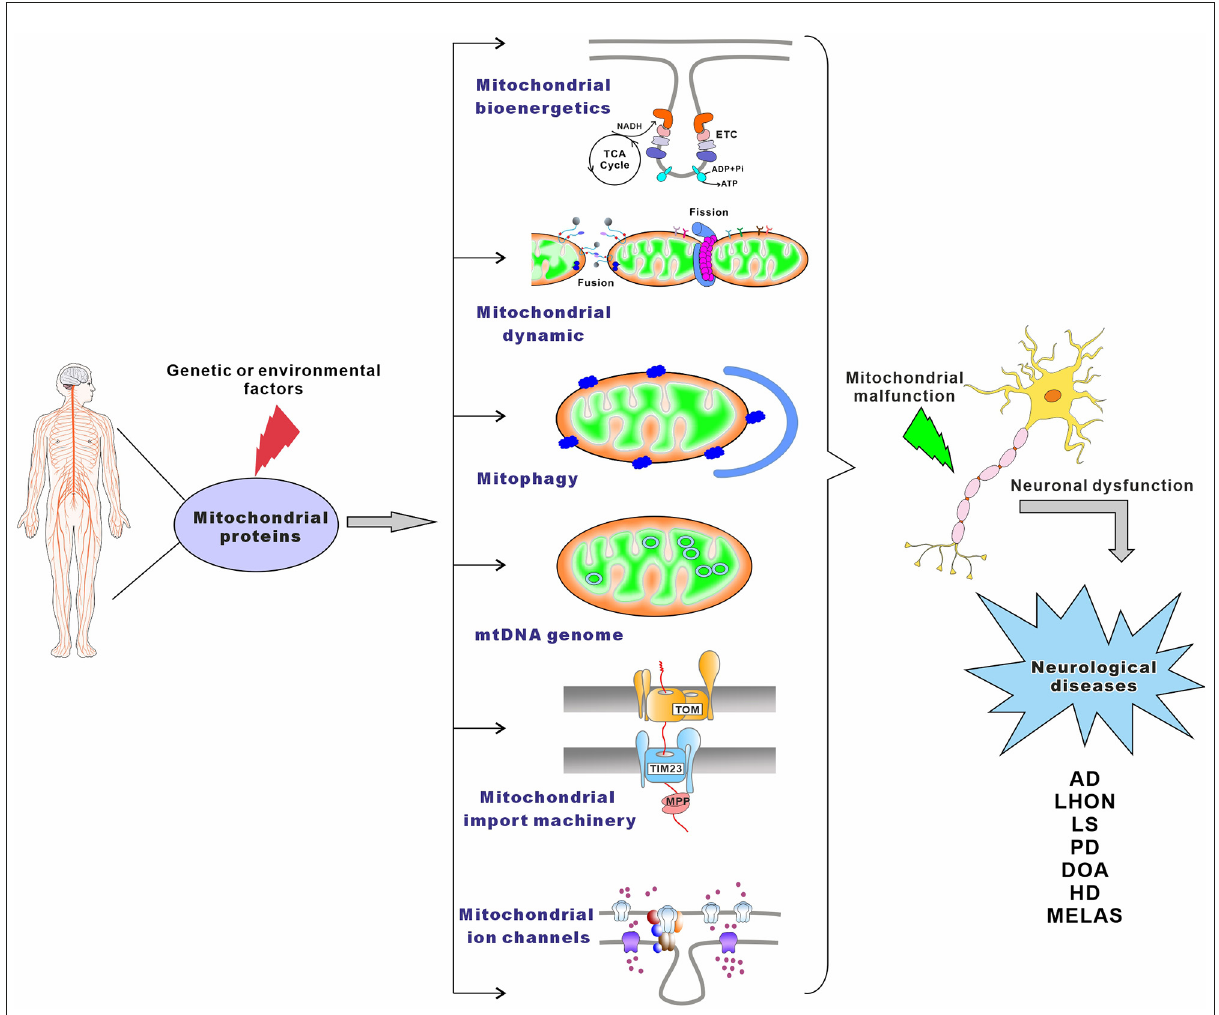
FIGURE1 The main pathways leading to mitochondrial-associated neurological disorders. Genetic or environmental factors can cause mutations of mitochondrial proteins, which lead to mitochondrial malfunction. Neurological disorders may result from damaged mitochondrial bioenergetics, imbalanced mitochondrial dynamics, defective mitophagy, impaired maintenance of mitochondrial genome, compromised mitochondrial importing machinery, altered mitochondrial ion channels, or combinations